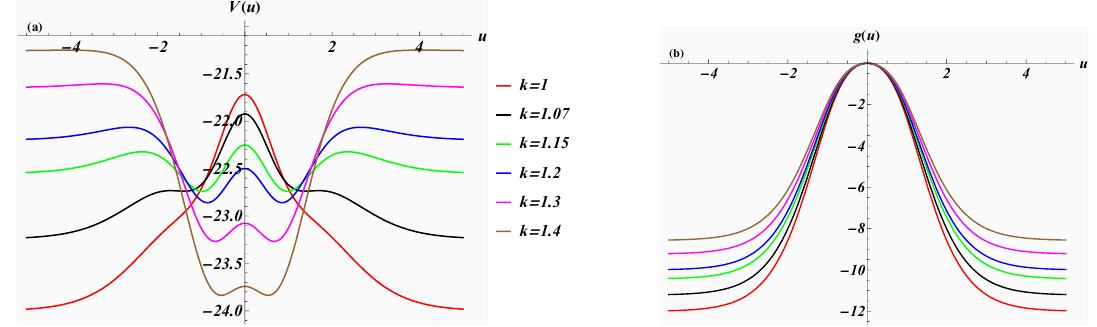
Figure 1 . Reduced potential (3.23) panel (a) and reduced metric (3.21) panel (b) resulting from the two-soliton solutions as functions of u for different values of the parameter k